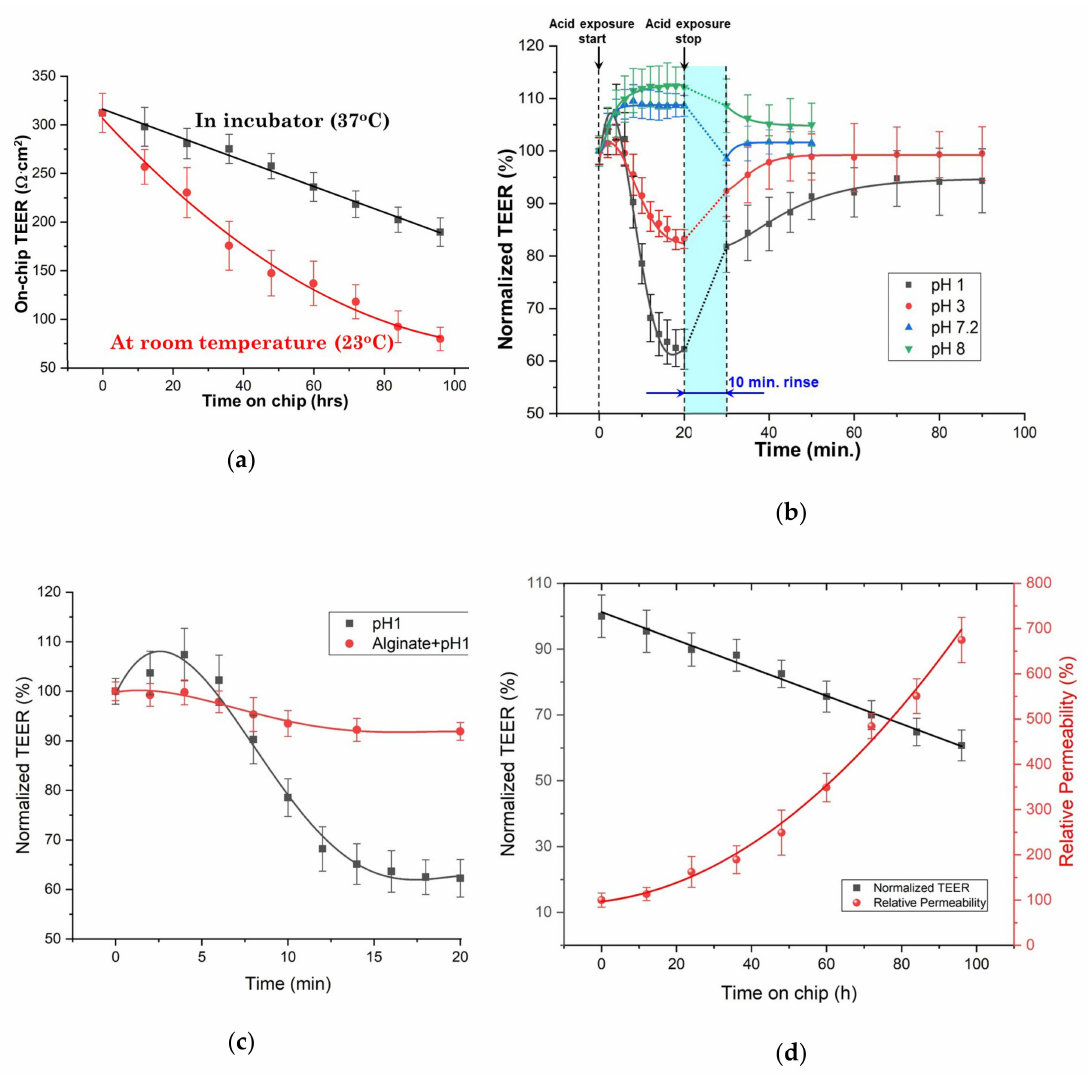
Figure 5. Data points for TEER measurements of tissues maintained in biochips in incubator and at room temperature, respectively. ( a ) On-chip TEER measurements of tissue viability ( n ≥ 5; R 2 = 0.991). ( b ) Normalized on-chip TEER responses of tissues exposed to media of di ff erent pH values ( n ≥ 3). ( c ) On-chip TEER responses of tissues exposed to acidic solution with pH 1, with or without